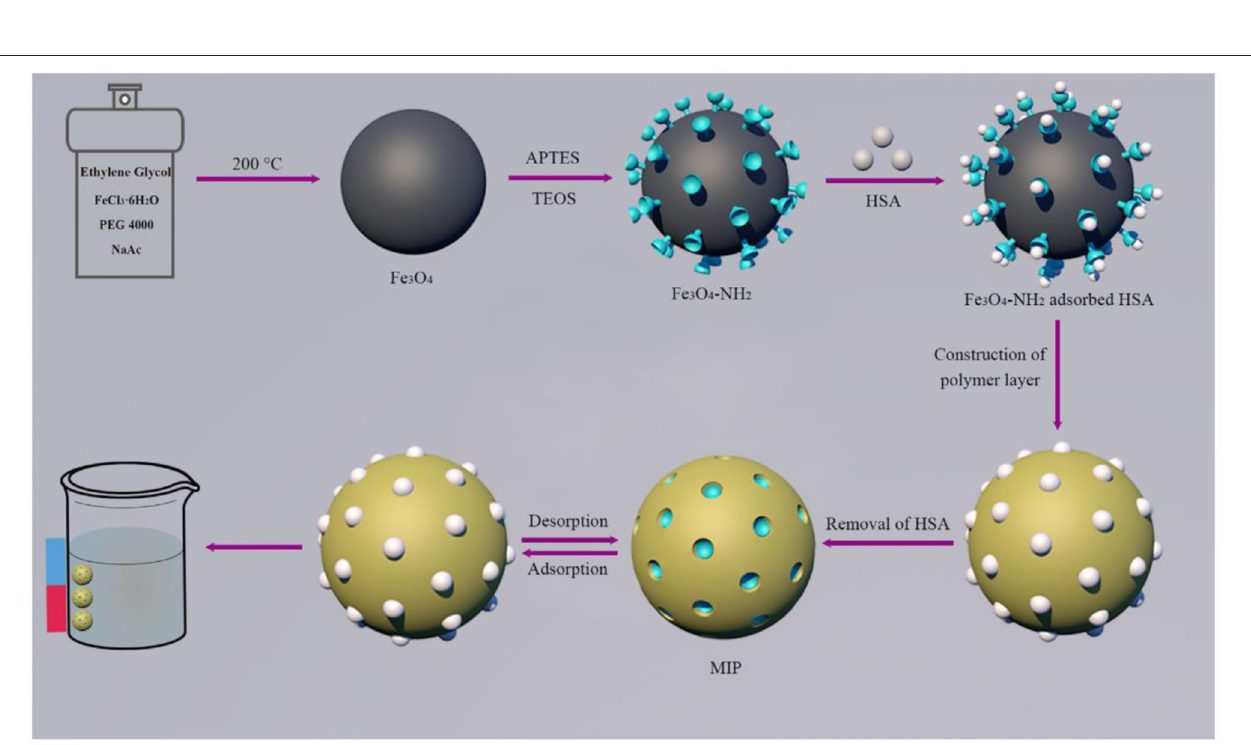
FIGURE 5 | The principle and procedure for the preparation of MIPs (Guoning et al., 2020). Reprinted with permission from Elsevier. Copyright (2020)